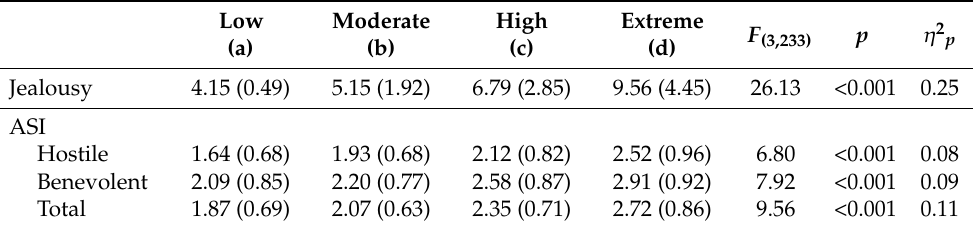
Table 5. Test scores on jealousy, hostile sexism, and ambivalent sexism according to emotional dependency categories.